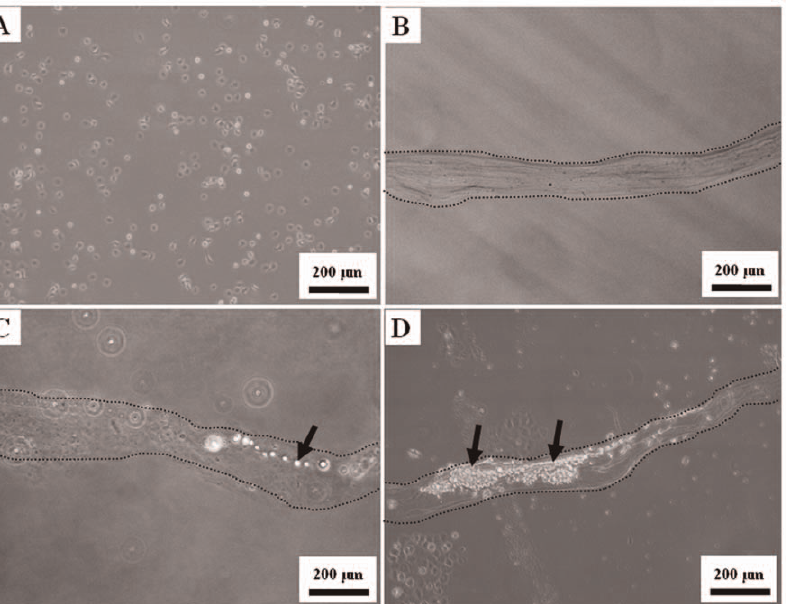
Figure 5. Cell culture of microfibers. Proliferation of GBM cells in microfibers. A. GBM cells; B. microfiber without cells; C. GBM in microfibers at the 1st day; D. GBM in microfibers at the 7th day. Arrows indicate GBM